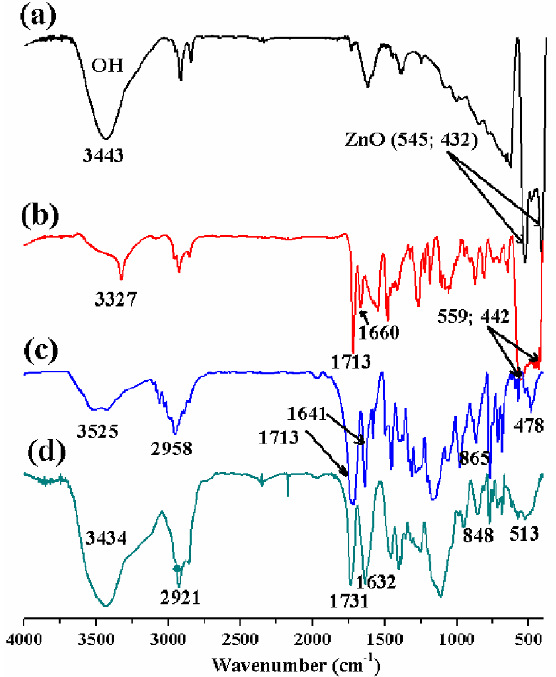
Figure 2. The FTIR spectra of the pristine ZnO nanoparticles (a), ZnO-BEI (b), ZnO-PCEMA-Br-2 (c) and ZnO-PCEMA- b - PEGMA-Br-2